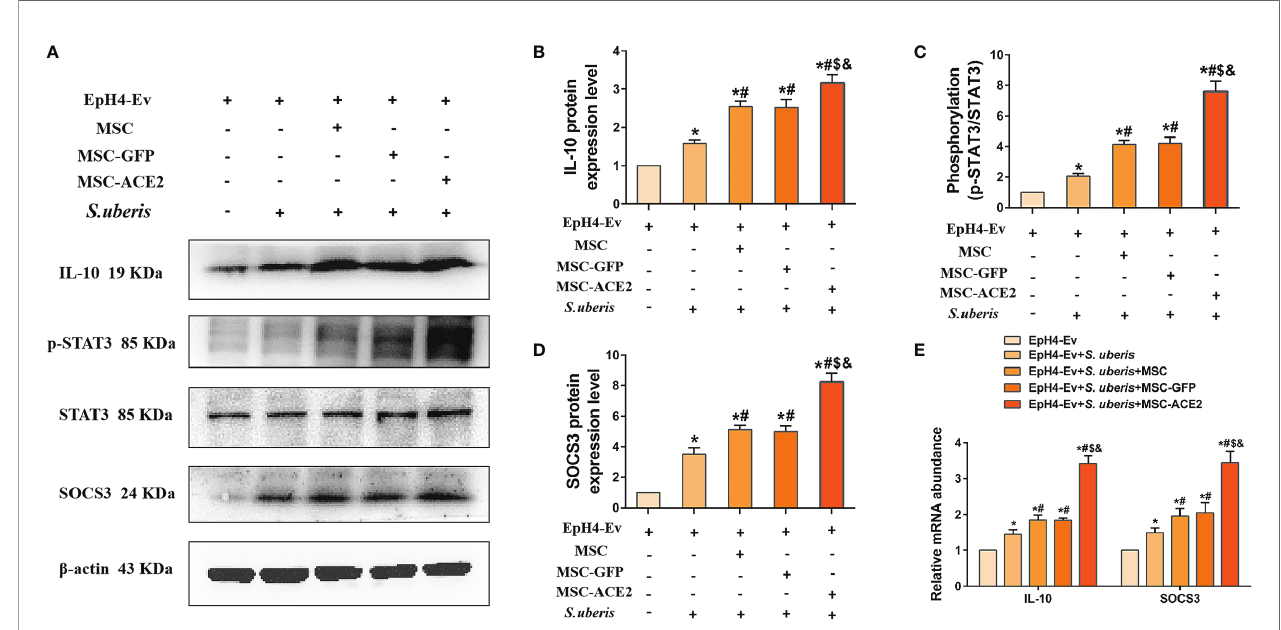
FIGURE 6 | Effect of MSC-ACE2 on IL-10/STAT3/SOCS3 signaling pathway. (A) Detection of relative protein expression levels of IL-10, phosphorylation levels of STAT3, STAT3, and SOCS3 by Western blot. (B-D) Statistics of the IL-10, phosphorylation levels of STAT3, STAT3, and SOCS3 Western blot results (n = 3). (E) Detection of relative transcript levels of IL-10 and SOCS3 in EpH4-Ev cells by qPCR (n = 4). Experiments were repeated three times and data were presented as the mean ± SEM. * P < 0.05 vs. EpH4-Ev; # P < 0.05 vs. S. uberis ; $ P < 0.05 vs. MSC; & P < 0.05 vs.